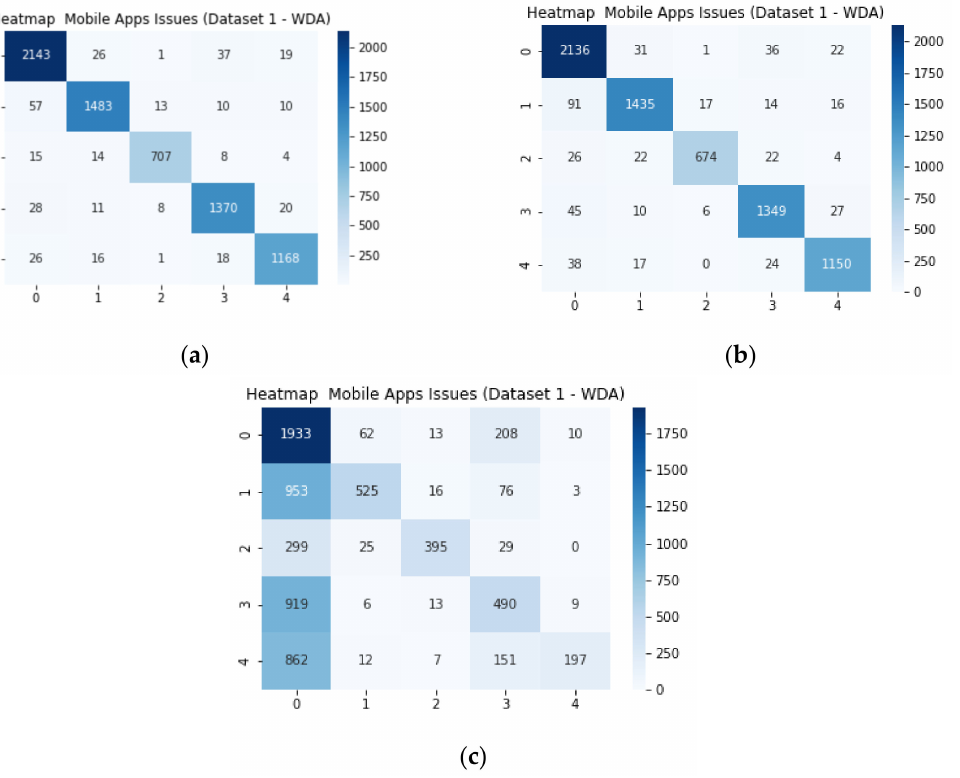
Figure 7. Confusion matrix for ML classifiers suing dataset 1 with data augmentation: ( a ) RF, ( b ) SVC, ( c )